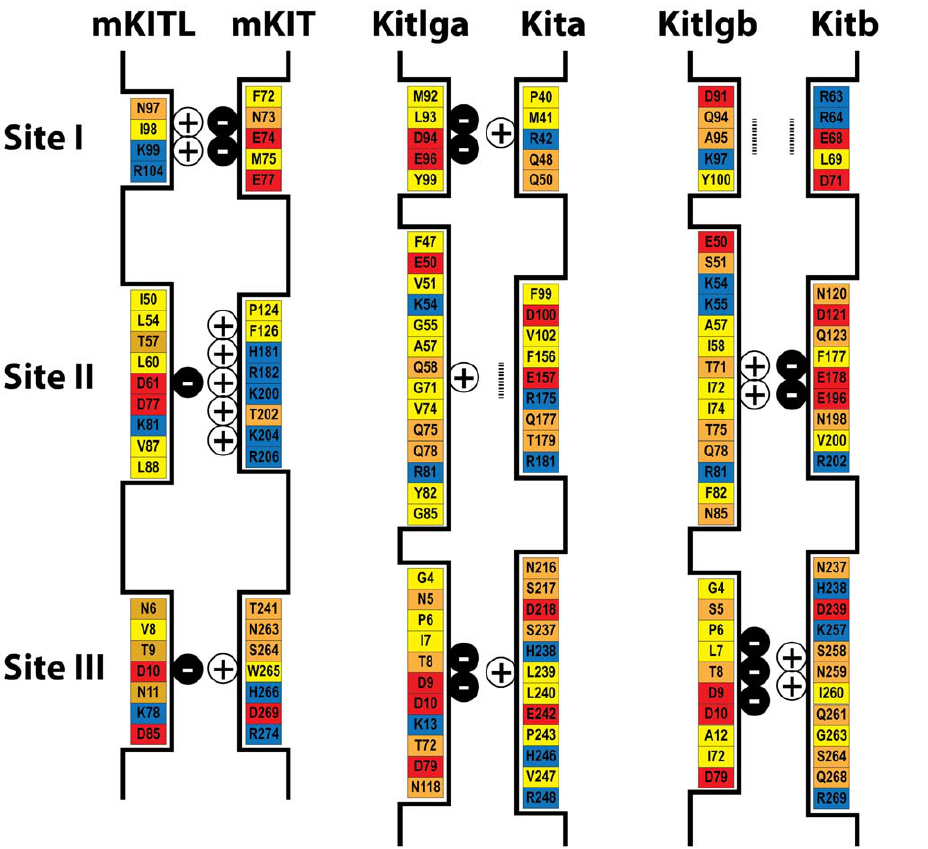
Figure 12. Schematic illustration of the three ligand-receptor binding sites and the amino acids involved in the mouse and zebrafish. The amino acids with negative charge, positive charge, polar and hydrophobic side chains are shown in red, blue, orange and yellow, respectively. The amount of net charges at each site is indicated by plus or minus signs, and the vertical dotted bar indicates neutral site.